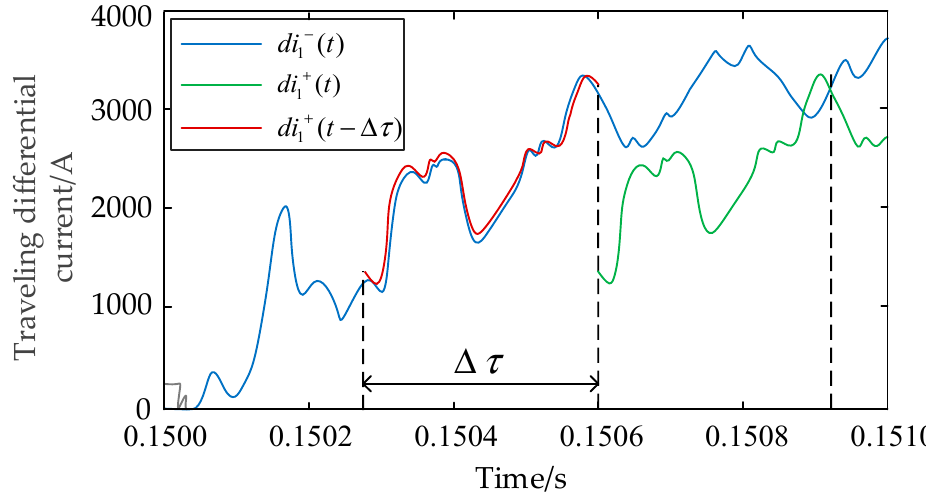
Energies 2022 , 15 , 7820